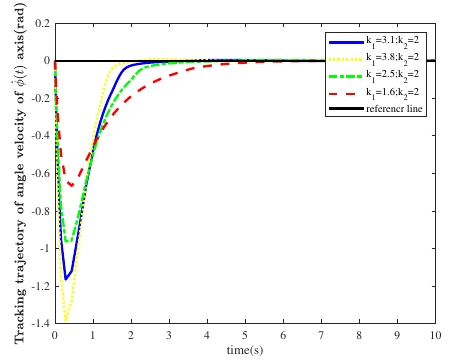
Figure 7. ˙ φ of different k 1 and k 2